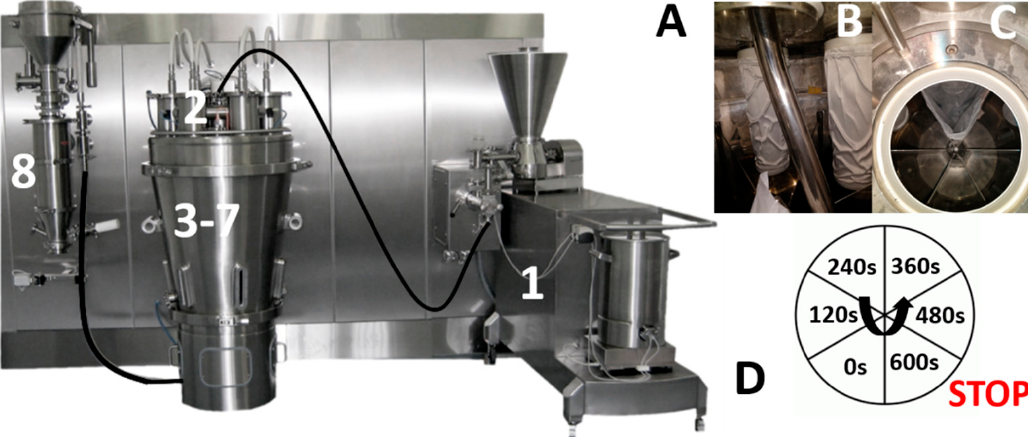
Figure 3. Overview of sample collection at different locations along the ConsiGma-25 line: ( A ) after the granulation module (1), after the wet transfer line (2), at different time points during drying (3–7), and after the conditioning unit (8). Tube ( B ) dividing the granules over the different cells transfers granules directly in a bag ( C ). Schematic overview of drying time corresponding to each cell when process was stopped ( D ).